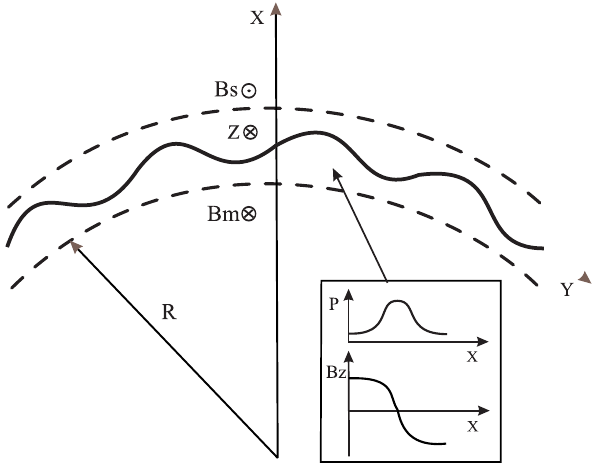
Fig. 3. Illustration for the first case with a fixed curved layer with reversal magnetic fields.